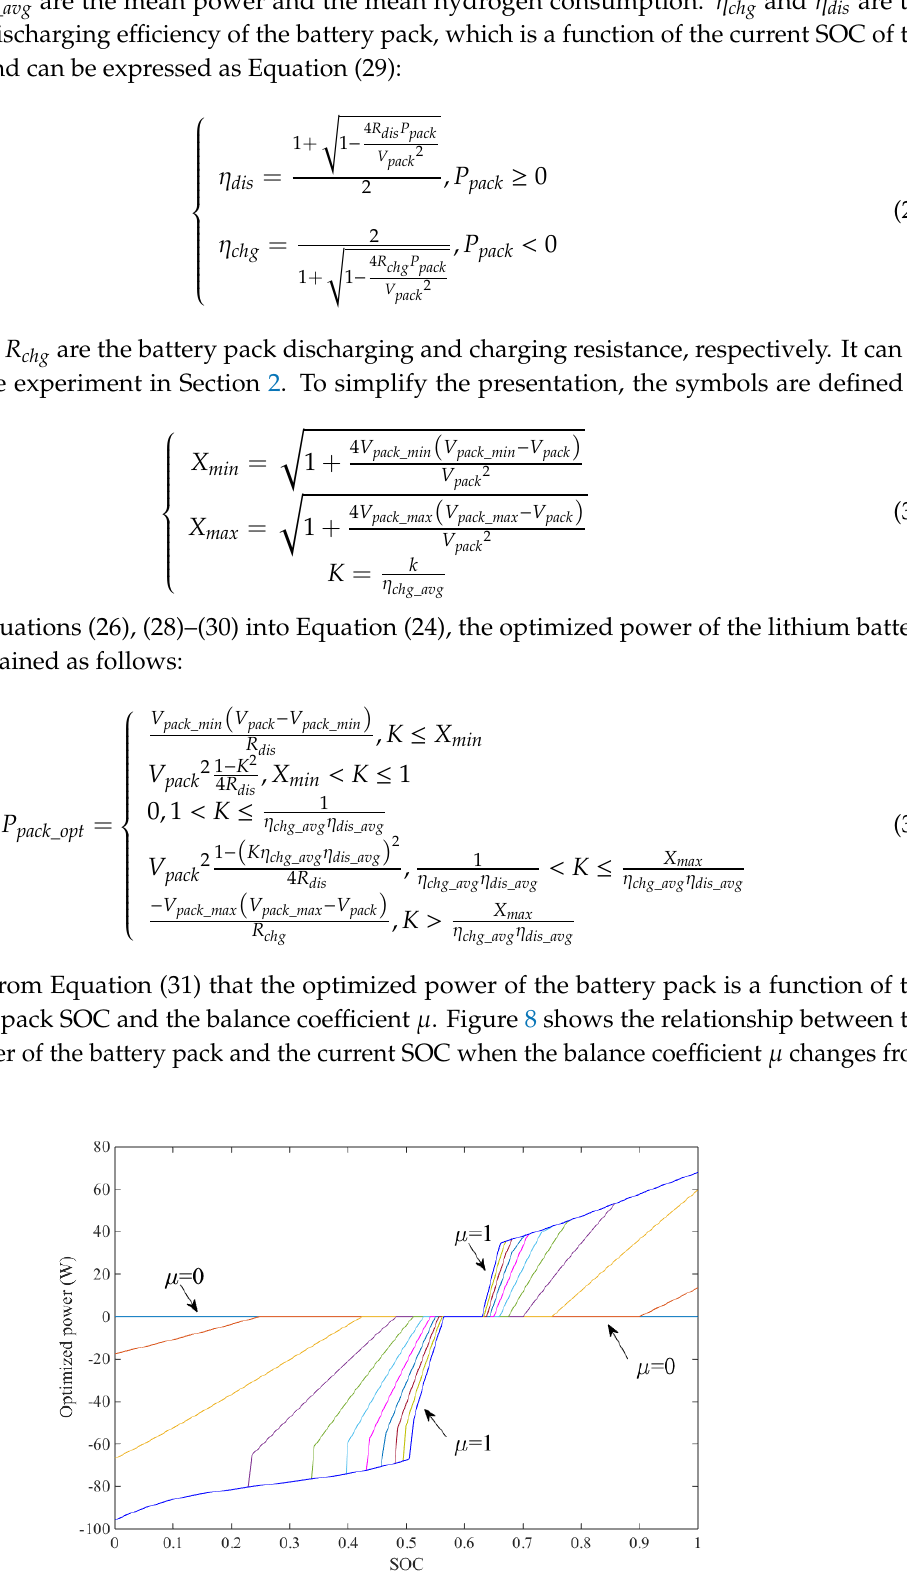
Figure 8. Relationship between the optimized power and state of charge (SOC).